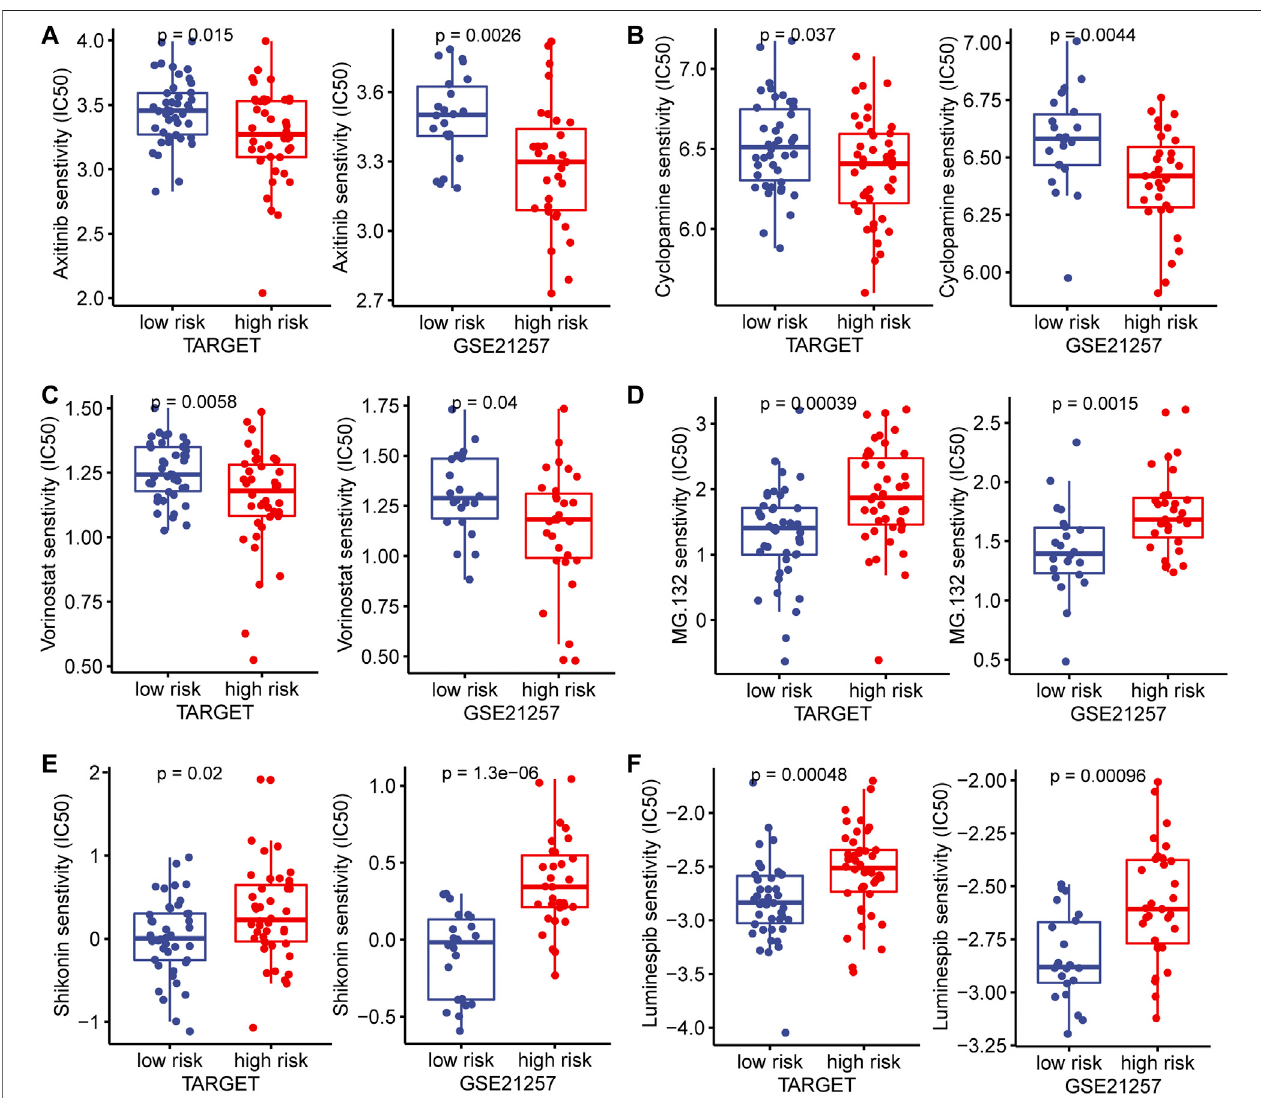
FIGURE 9 | In the TARGET and GSE21257 cohorts, high- and low-risk patients and targeted drug sensitivity. (A) Axitinib (B) Cyclopamine (C) Vorinostat (D) MG.132 (E) Shikonin (F) Luminespib.